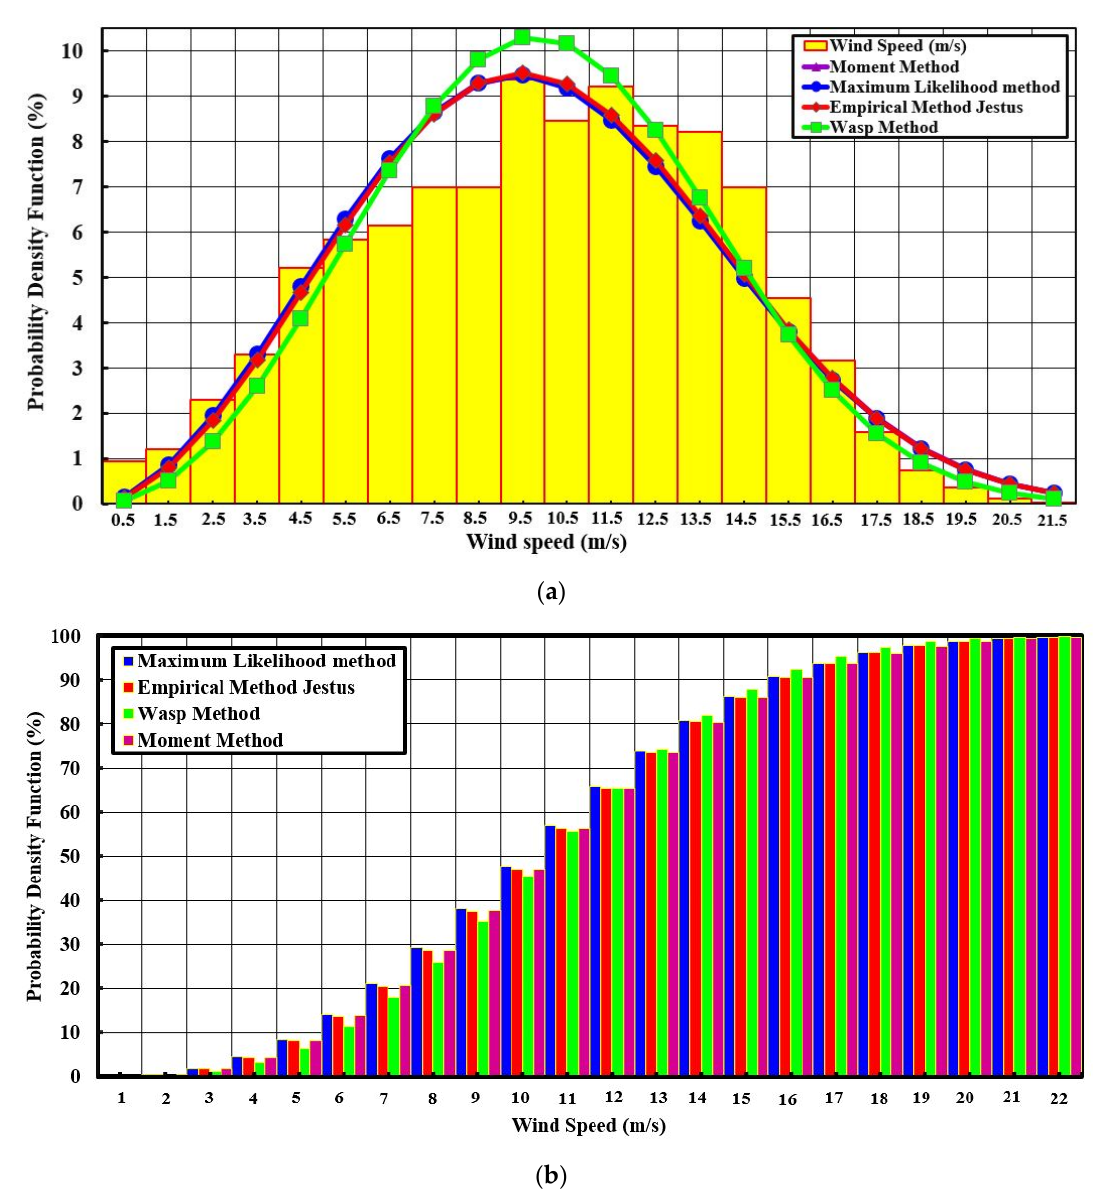
Figure 6. ( a ) Annual 80 m wind speed Weibull distribution (PDF) and ( b ) cumulative distribution function (CDF) at level of 80 m for Ghoubbet.